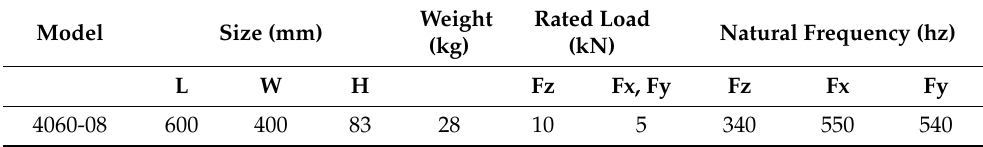
Table A3. Plantar pressure insoles technical specifications (Novel gmbh, PedarX) [40].